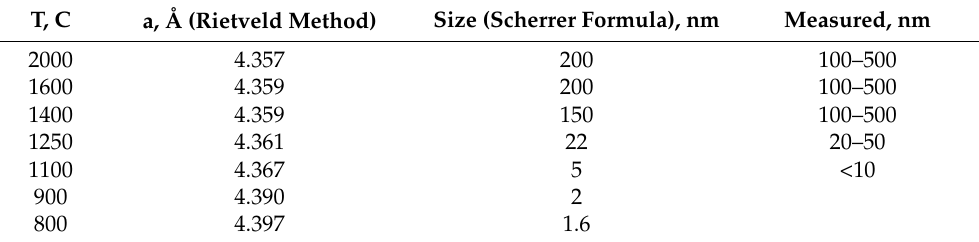
Figure 2. ( A ) Diffraction patterns of SiC powders synthesized at different temperatures by pyroly- sis of C 12 H 36 Si 6 . ( B ) the XRD pattern background of one sample and Mylar sample holder with no signs of the strongest 002 graphite peak in the patterns. Table 1. Synthesis temperature (T), lattice parameter (Rietveld analysis), and crystallite size (Scherrer formula) for various SiC samples. Example of crystal size distribution at 2000 °C is given in Figure S2 of Supplementary Materials.